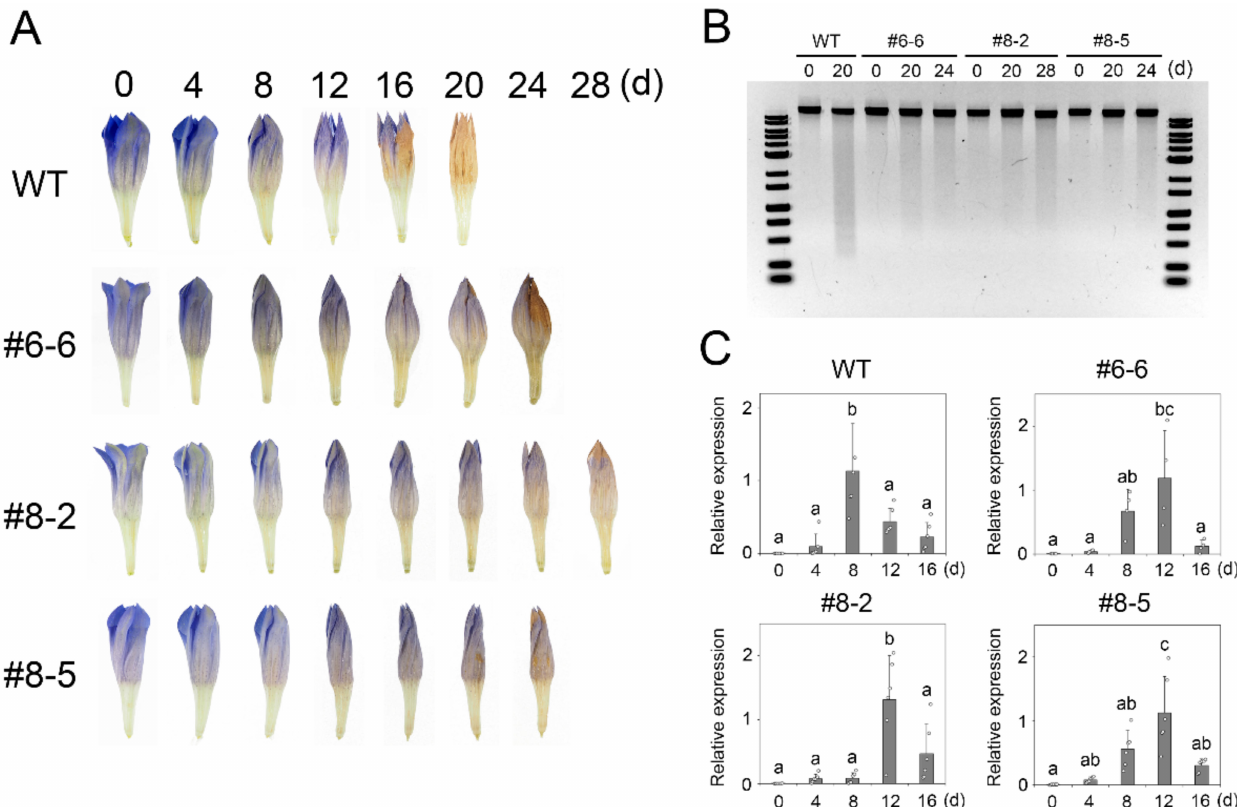
Figure 5. Evaluation of the flower longevity of eph1l genome-edited knockout mutant lines (#6-6, #8-2, and #8-5) lines. ( A ) Changes in corolla appearance every 4 days. ( B ) Image of the agarose gel electrophoresis of the genomic DNA from wild type (WT) and three eph1l lines before and after dark- induced senescence treatments. ( C ) The relative expression level of SAG12 from WT and three eph1l lines determined by quantitative reverse transcription polymerase chain reaction ( n = 4–6). Different letters indicate significant differences during the 16 d treatment period in each line (Tukey–Kramer test, p <